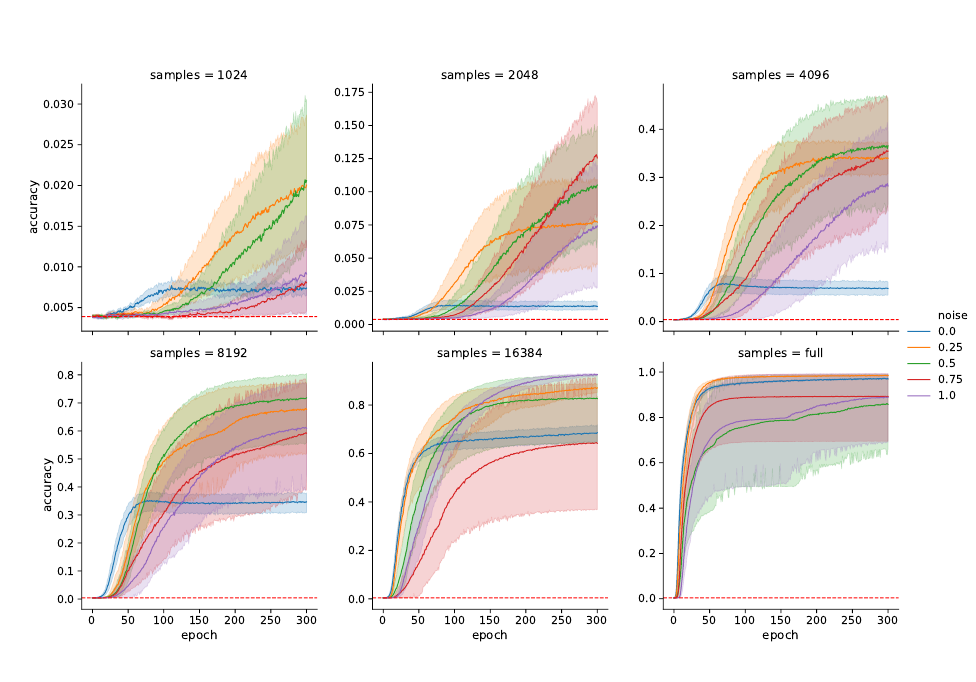
Figure 8: RD Network on DPAv4 dataset